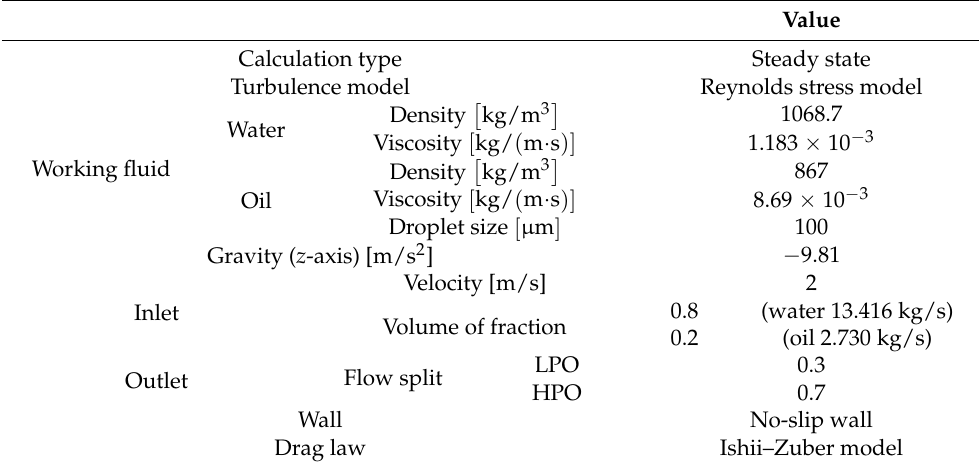
Table 1. Boundary conditions applied in this